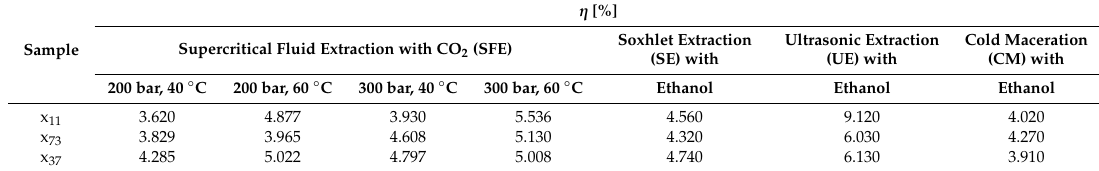
Table 1. Yields ( η [%]) obtained for extraction